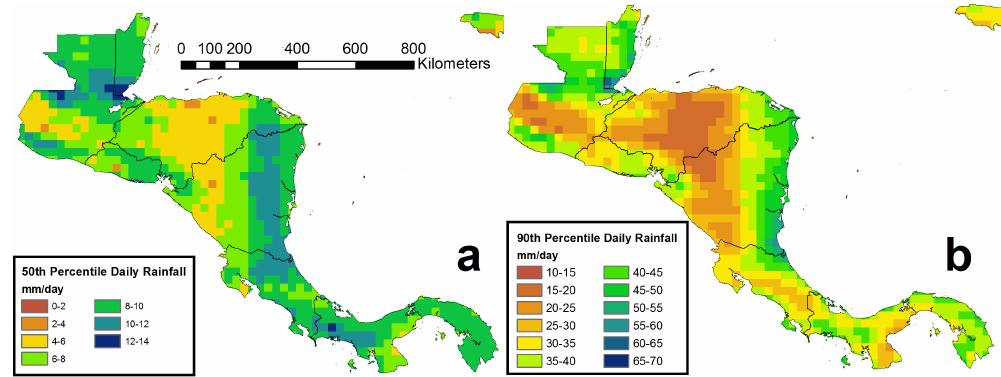
Figure 3. Maps showing rainfall values in mmday − 1 for (a) 50th and (b) 90th percentiles calculated from TMPA daily rainfall estimates covering the years 2001–2013. These two percentile maps were used within the decision tree framework to produce moderate landslide hazard